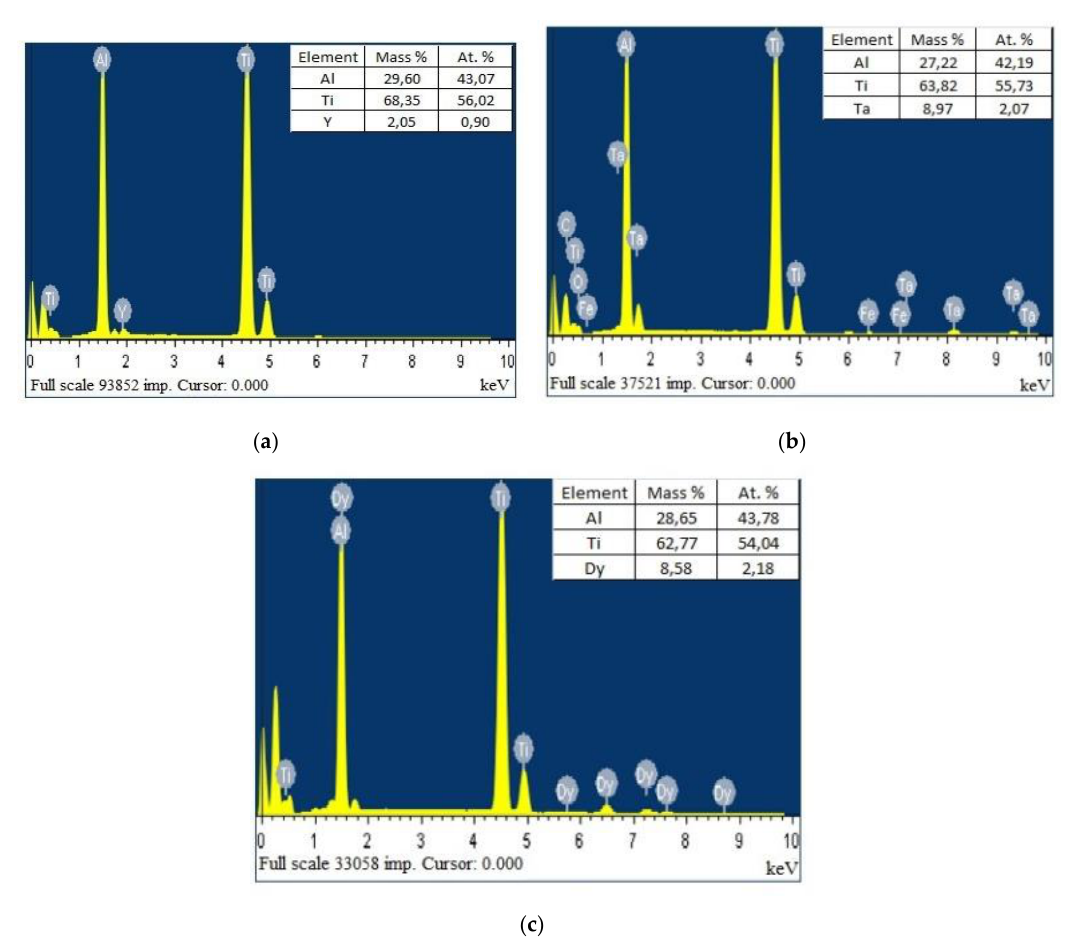
Figure 3. EDX-spectra and elemental composition of the TAY ( a ), TAT ( b ) and TAD ( c ) alloys.